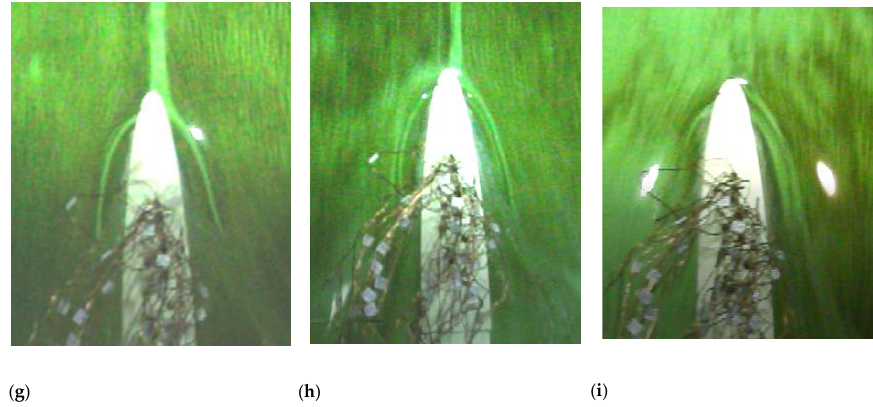
Figure 8. Dependence of the shape of the retaining waves on the speed of motion of the model.